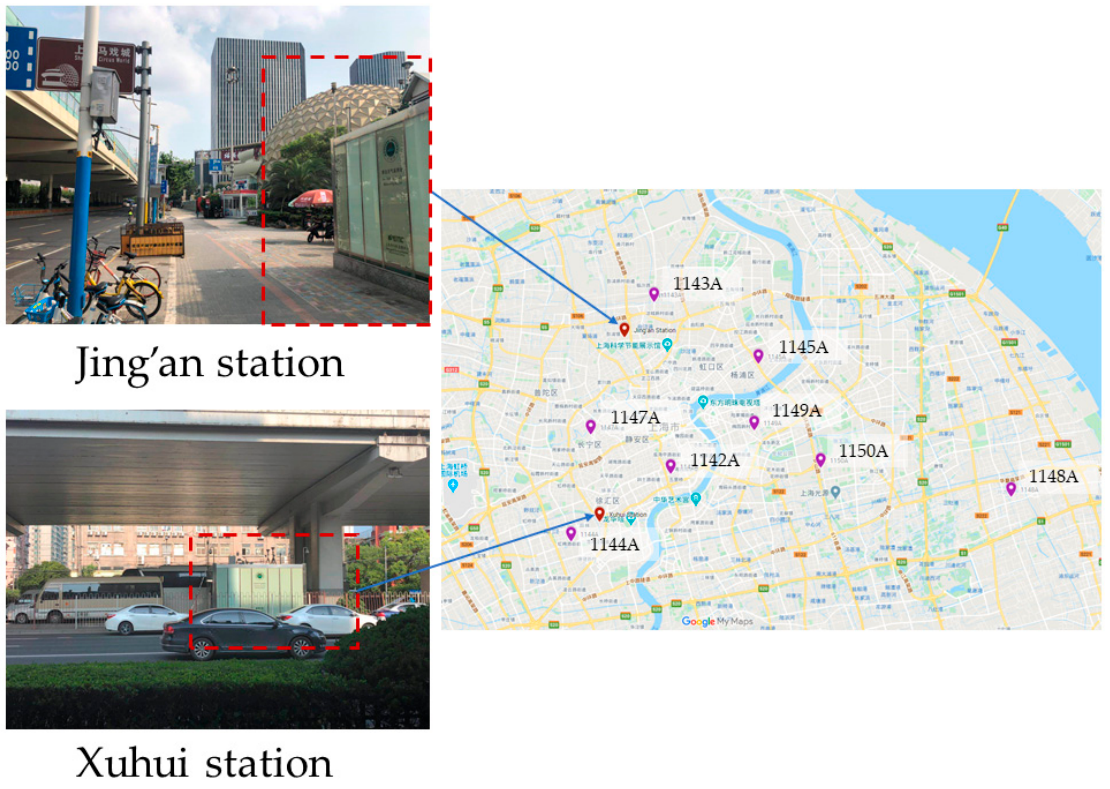
Figure 1. The spatial locations of roadside and urban air quality monitoring stations.